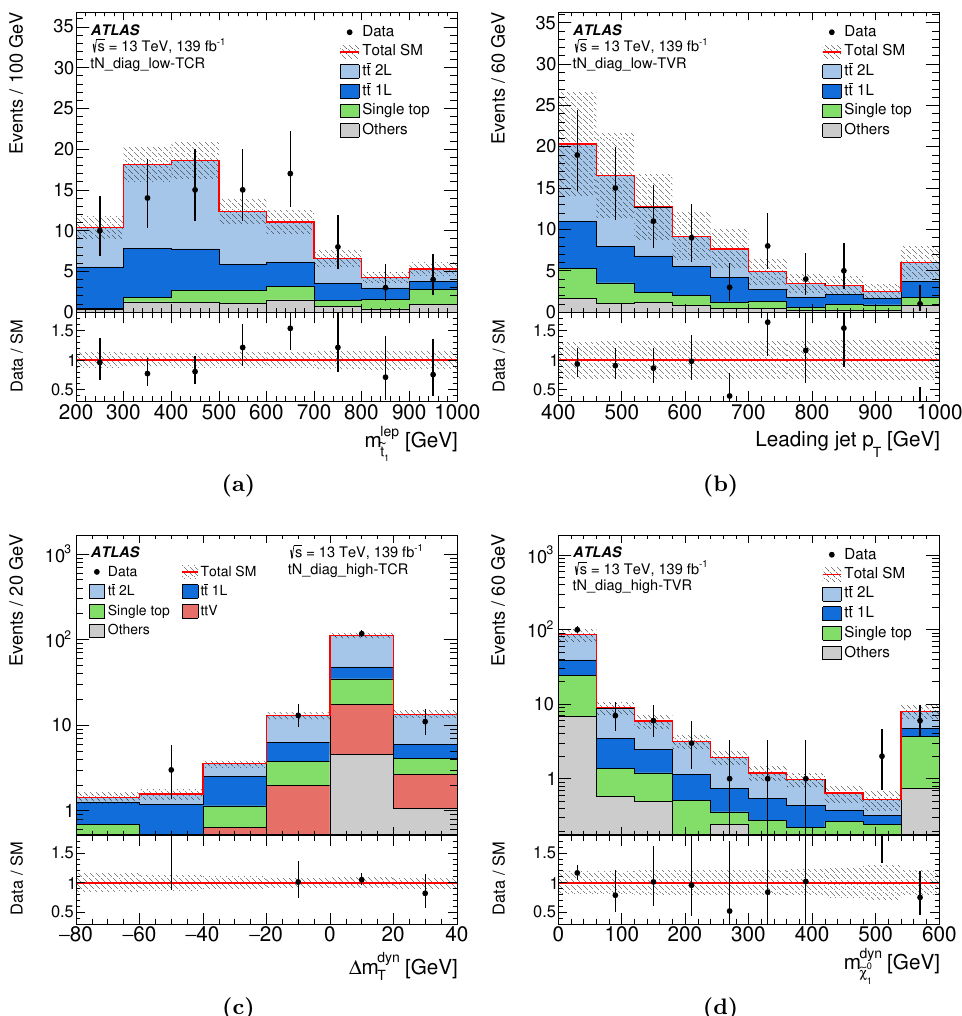
Figure 6. Selected kinematic distributions in tN_diag_low and tN_diag_high TCRs and TVRs: (a) m lep in the tN_diag_low TCR, (b) leading jet p T in the tN_diag_low TVR, (c) ∆ m dyn ˜ t 1 in the tN_diag_high TVR. The distributions shown are post-fit, i.e. tN_diag_high TCR, (d) m dyn ˜ χ 0 1 each background is scaled by a normalisation factor obtained from a background-only likelihood fit to the CRs (see table 14). The hatched area around the total SM prediction and the hatched band in the Data/SM ratio include all statistical and systematic uncertainties. The last (first) bin contains overflows